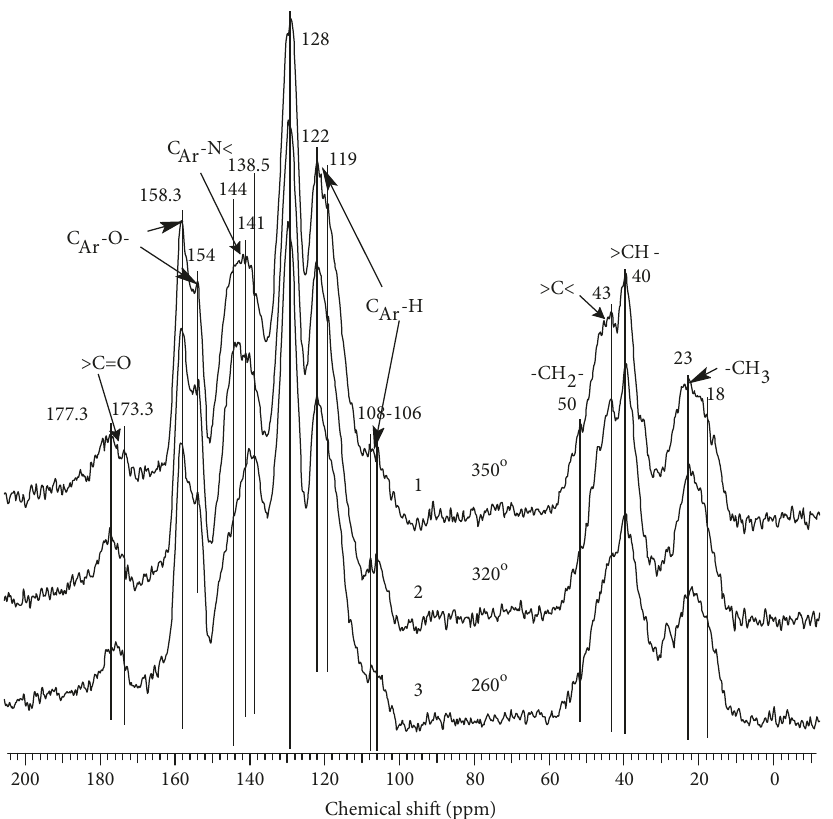
Figure 9: 13 С NMR spectra of ROL-II- (75 wt.%) m- PDA (25 wt.%) blends, cured in the thermal regime up to the following T 1: 350; 2: 320; 3: 260.